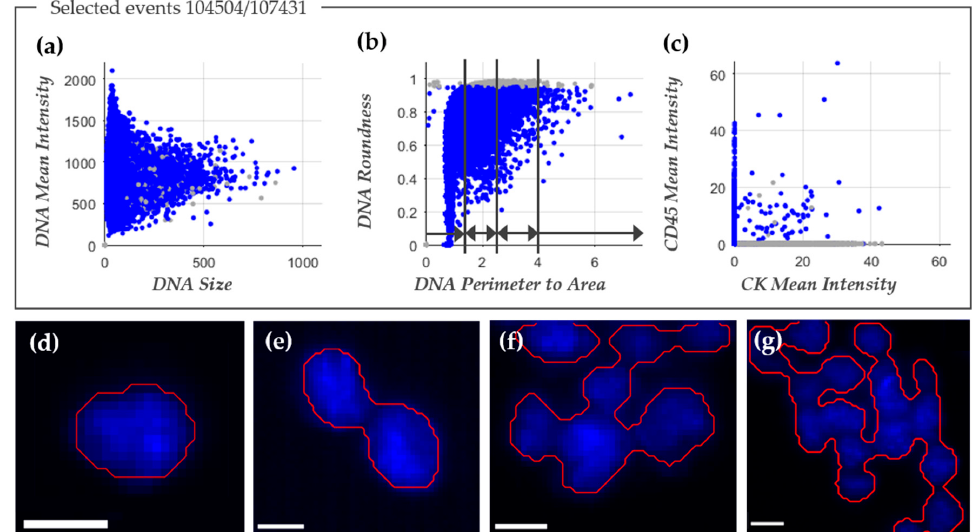
Figure 1. ACCEPT identification of nucleated cells. The three scatter plots in panels ( a – c ) were used to define nucleated cells (depicted in blue) by ACCEPT. In total, 104,504 events were detected and 107,431 of them were classified as nucleated cells, whereas the other events are depicted as grey dots. The division into single cells, doublets, small, and large clusters was based on DNA perimeter to area ratio, as illustrated in panel ( b ). In the scatter plot in panel ( c ), the mean fluorescence intensity of Cytokeratin (CK)-phycoerythrin (PE) (CK mean intensity) is plotted against the mean fluorescence intensity of CD45-allophycocyanin (APC) (CD45 mean intensity). In panels ( d – g ) typical examples of the segmentation (red line) around the nucleus of a single cell are illustrated in panel ( d ); of a doublet in panel ( e ); a small cluster in panel ( f ); and a large cluster in panel ( g ). The white scale bar represents 10 pixels, which corresponds to a size of 6.4 µ